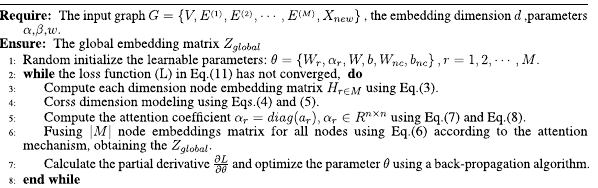
Algorithm 1. The proposed